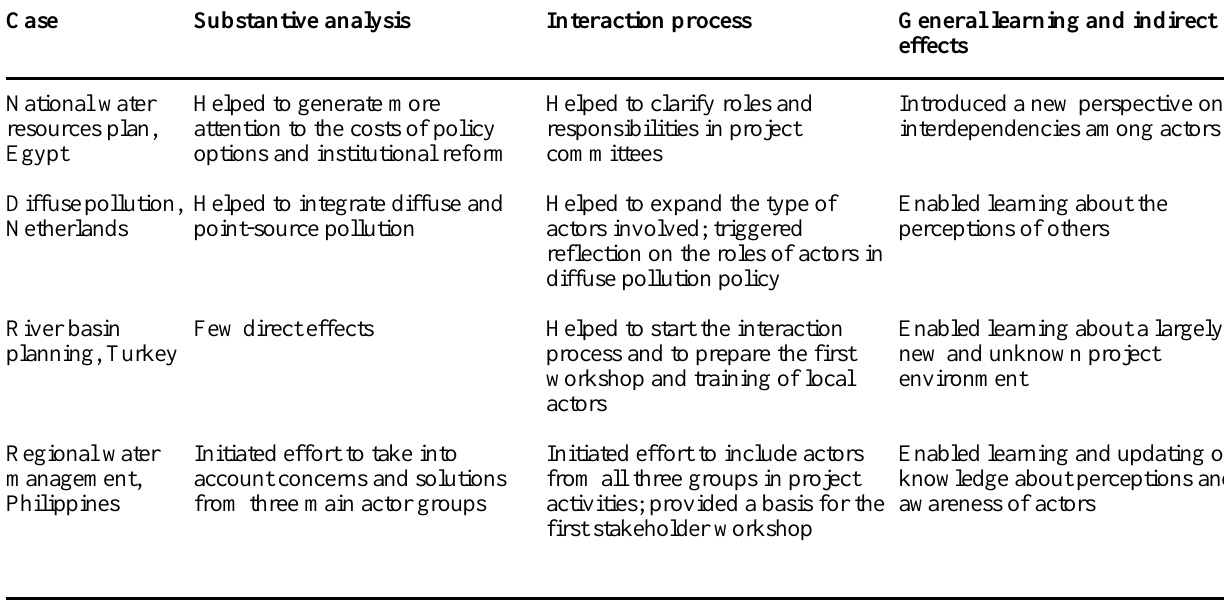
Table 4. Use of the actor analysis: effects of the actor analysis on project